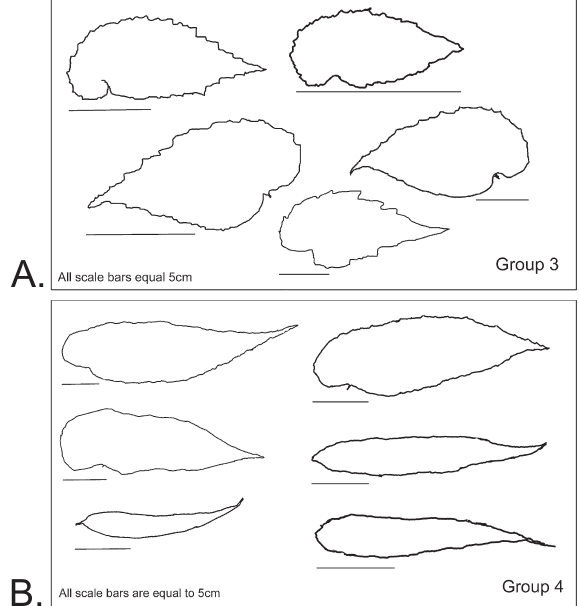
Fig. 3. Leaf tracings. A . Group 3: lanceolate, dentate and very asymmetric leaves. B . Group 4: linear to lanceolate, and entire to denticulate